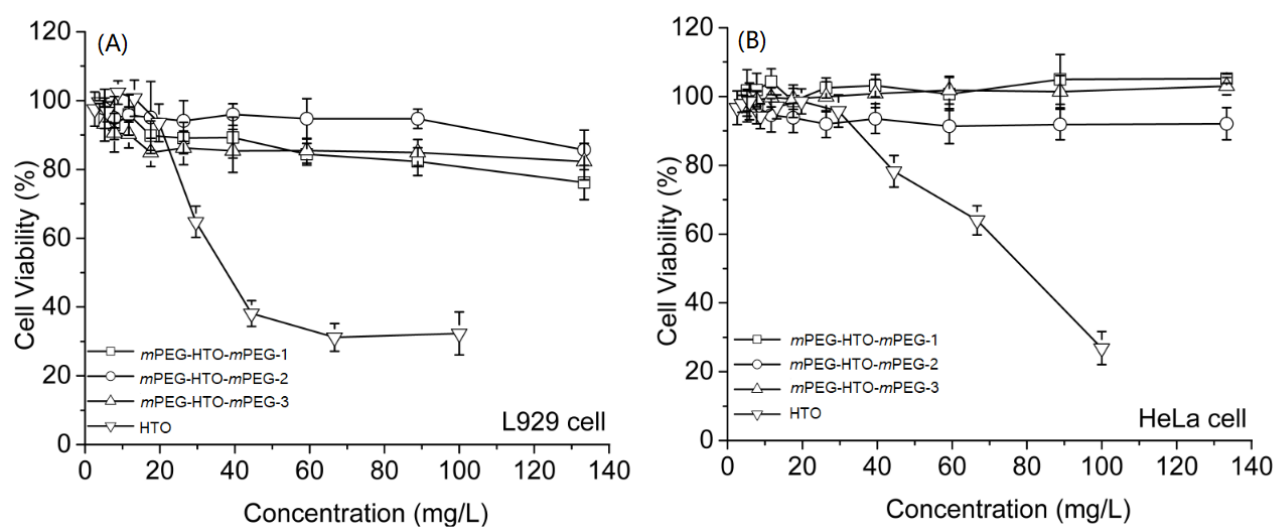
Figure 7. In vitro cytotoxicity of m PEG-HTO- m PEG in (A) L929 and (B) HeLa cell lines at different concentrations.